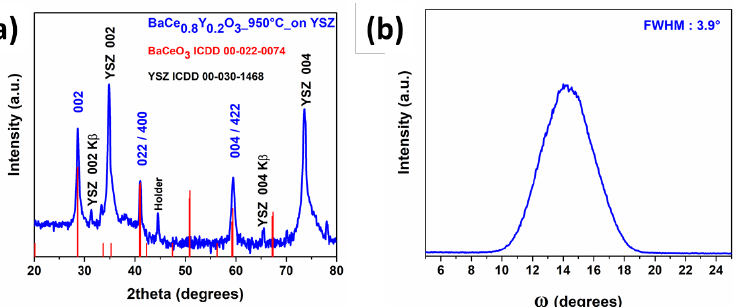
Figure 6. ( a ) XRD pattern and ( b ) rocking curve of the 002 reflection of Y-doped BaCeO 3 thin film grown on the YSZ (100) substrate at a deposition temperature of 950 °C.